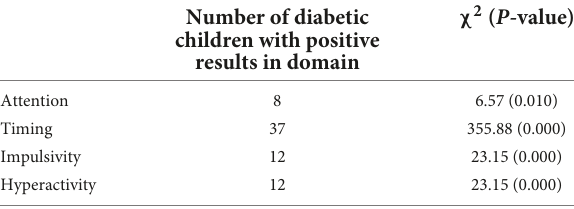
TABLE 3 Rate of positive MOXO continuous performance test (MOXO-CPT) scores in the study cohort, defined as a score of “rank 4.” Number of diabetic children with